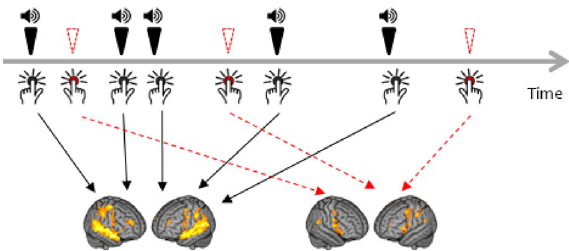
Figure 1. Overview of the experimental paradigm. Throughout the 10 min, 10 s scanning period, participants pressed a button with their right index finger when they experienced an auditory hallucination (red), and with their left index finger when real speech was presented through headphones